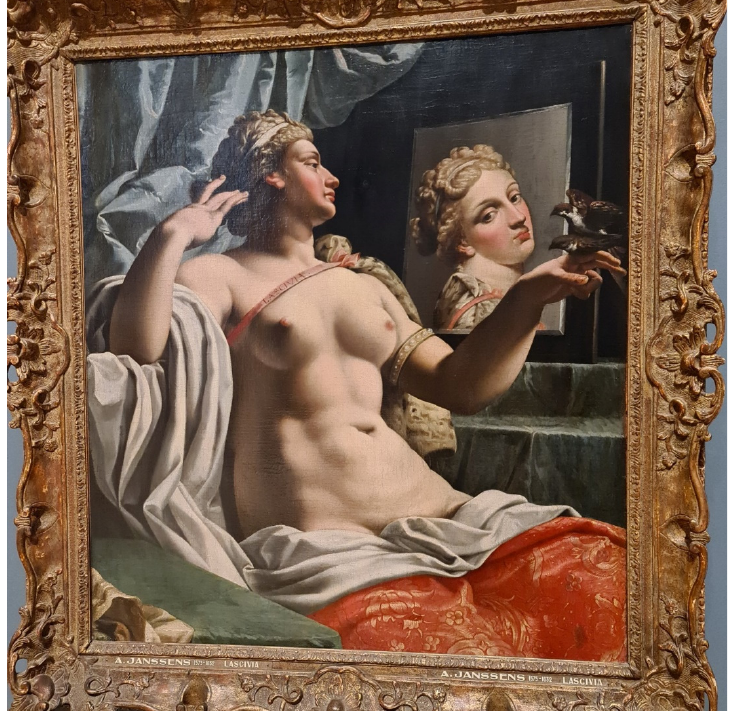
Figure 14. Abrahams Janssens. Lascivia (c. 1618) Musée Royaux des Beaux-Arts, Brussels. 14 Back to our poster/image: the “Swan” is represented not in immediate contact with the “Leda,” but interacting with her indirectly—through the ice cream cone. Nevertheless, the erotic drive is clearly outlined by the red-color sequence identified above: the ice cream ball; the bracelet on the girl’s forearm; the pink flower in her hair; the top of the bathing suit. This colorful dotted line then breaks off, but its erotic connotations are picked up by the suggestive folds of the white dress that simultaneously hide and accentuate (thanks to the caressing breeze and the torso’s dancing curves) the desired female groin, locus amoenus , to which they definitely point. Incidentally, the white does not appear all that innocent here, as it is also the color of the seagull, who embodies passionate desire (gastronomic and sexual), and whose phallic left wing, the one closest to the girl and sug- gestive of erection, plays with the transition from white to black (the pitch-black at the top of the wing forming a pattern with the black of the girl’s hair and of the cell phone). In fact, the interplay of the two white-and-black figures is more ambiguous than it may seem at first glance. The “Swan,” represented by a seagull ( chaika ), a bird, in Russian, of the feminine grammatical gender, plays—with respect to the distinctly phallic outline of the ice cream cone—an admittedly female oral sexual role: licking the penis ( fellatio ). The corresponding connotations of consuming ice cream are well-known and a popular topic of discussion. 15 As a result, the seagull turns out to be not only the seductive girl’s symbolic male partner, but also her alter ego / Doppelgaenger . This enriches her erotic reper- toire and expands the poster’s potential sex appeal. To be sure, there is more to the “White Wind” poster than its subliminal eroticism. The image of a bird coming down from the sky at the call of a human being, not necessarily